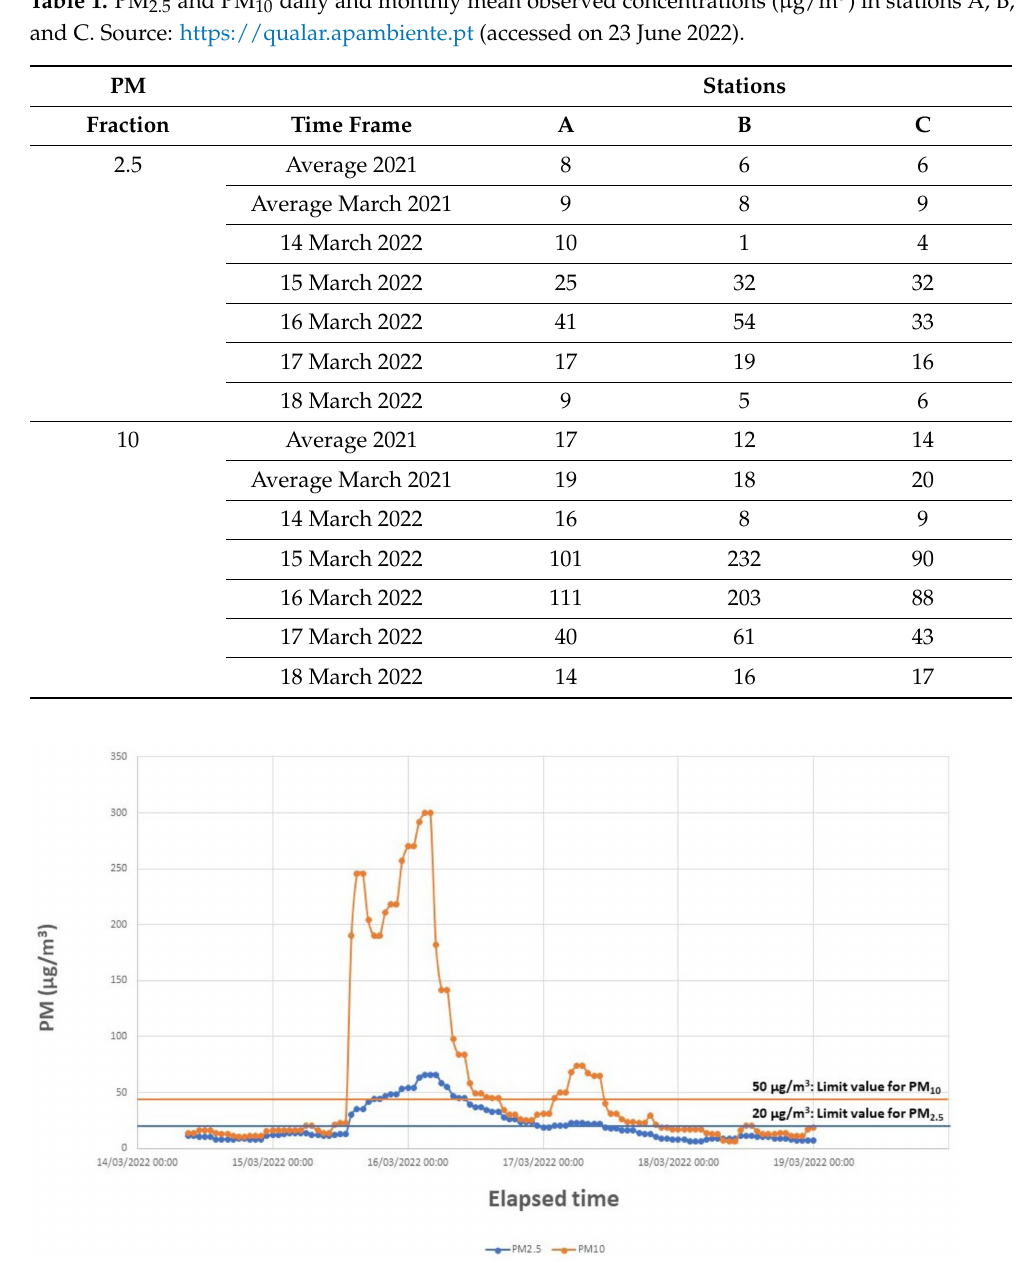
Figure 4. Graphical results of outdoor PM 2.5 and PM 10 concentration on Ervedeira station (A) from 15 to 17 March 2022. Limit values according to European legislation [15]. Source: https://qualar. apambiente.pt (accessed on 23 June